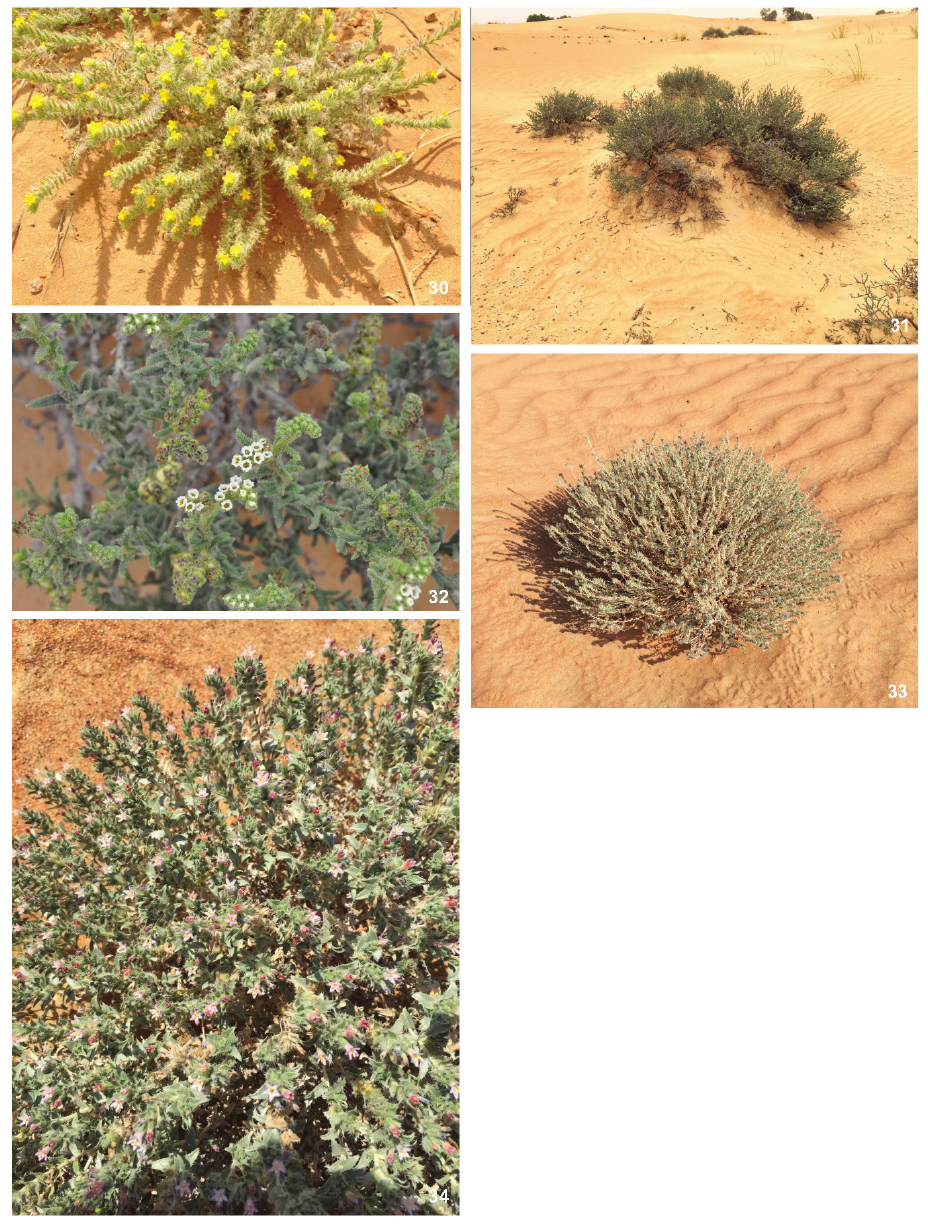
The associations with Celonites jousseaumei are of further interest when considered together with a close association of this pollen wasp with Heliotropium in Morocco (Volker Mauss, pers. com.) and close associations between Heliotropium and other masarines, Trimeria buyssoni Brethes in South America (Neff and Simpson 1985)